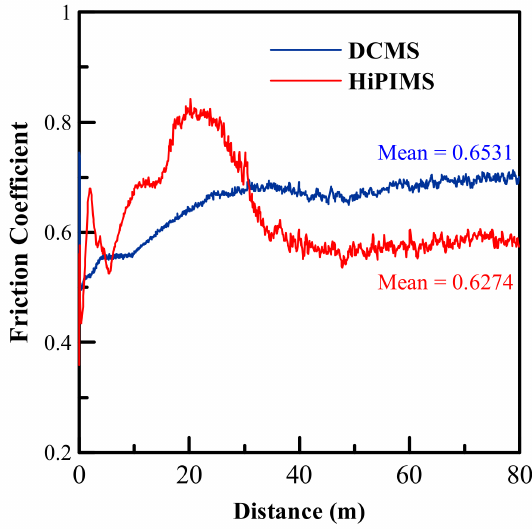
Figure 4. Variations of friction coe ffi cient with sliding distance for two di ff erent TiN coated HSS. The ball-on-disc abrasive test was conducted at room temperature condition with a 100Cr6 steel ball.